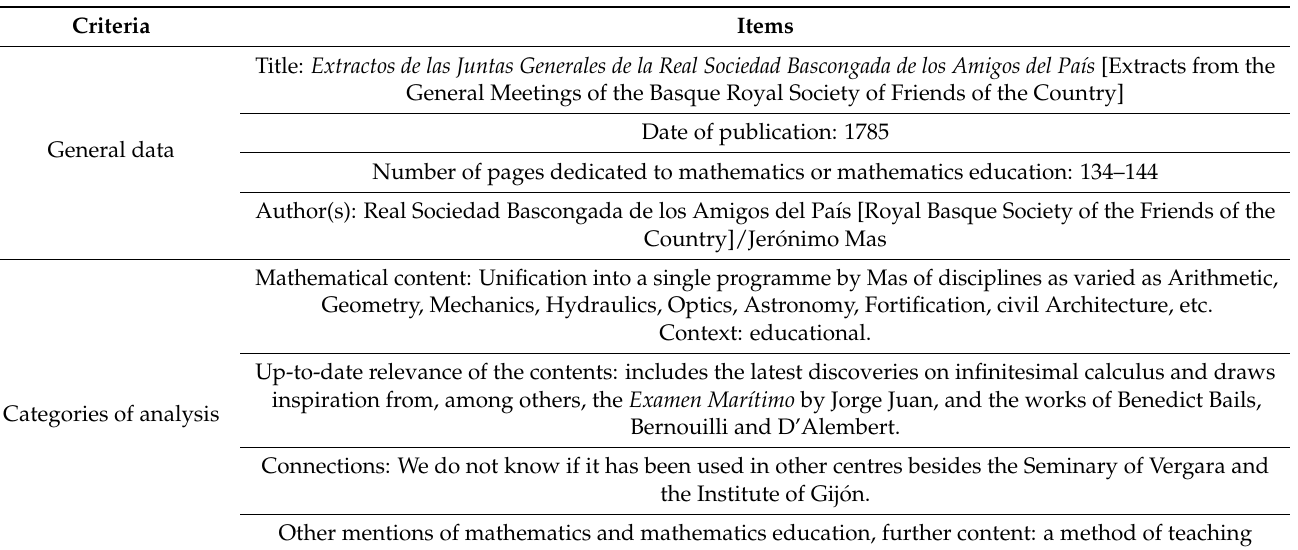
Table 2. Analysis of the mathematical content and mathematical education in the study plan for the training of Sailors and Miners followed at the Royal Asturian Institute of Nautical Studies and Mineralogy by Jovellanos at the end of the 18th